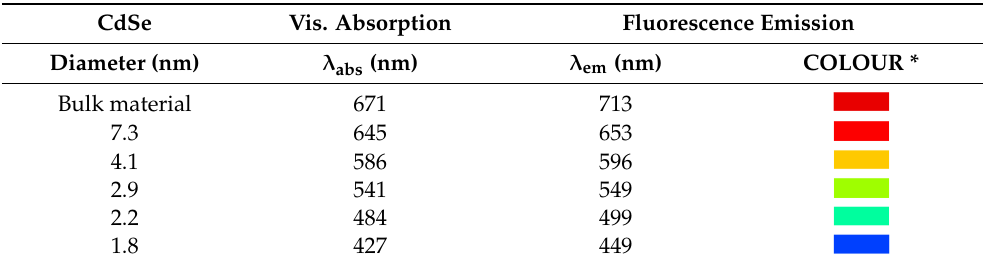
Table 1. Maximum wavelength values for fluorescence emission and visible absorption shown by CdSe as bulk material and as QDs with particle diameters in the range 1.8–7.3 nm. CdSe Vis.